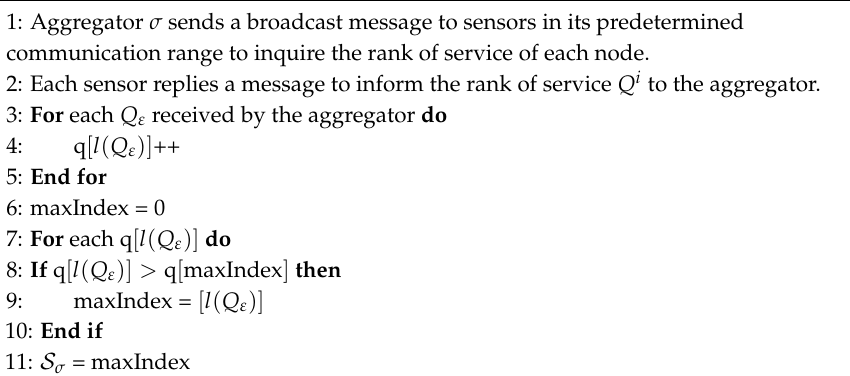
Algorithm 1 Configuration of Service Tag of Aggregator σ